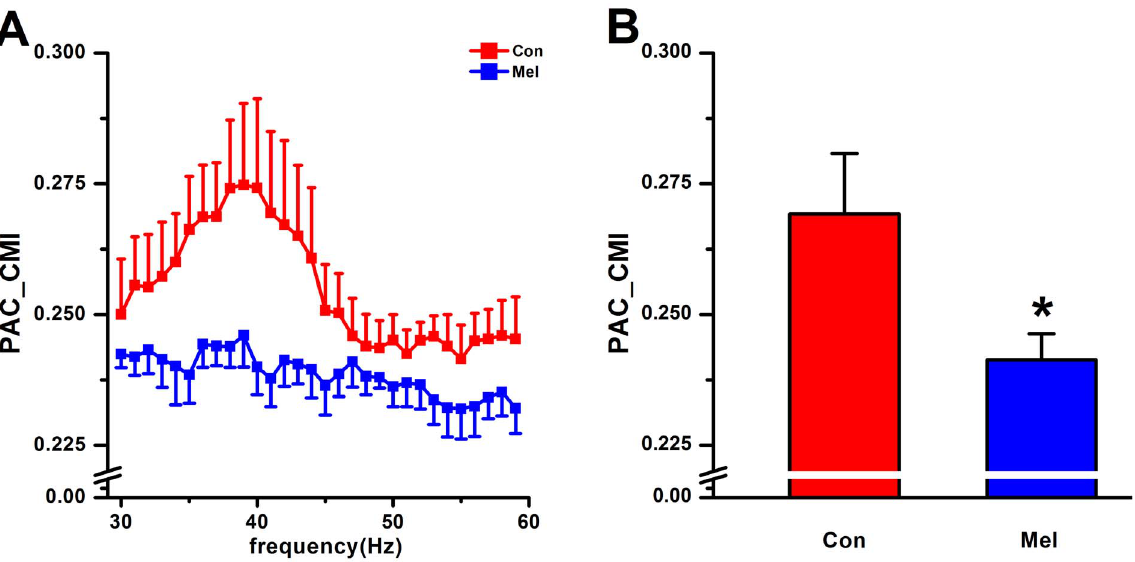
Figure 5. PAC-CMI analysis in CA3-CA1 network in Con and Mel groups. A. The comparison of coupling strength measured by PAC-CMI between Con and Mel groups ranged from 30 Hz to 60 Hz. B. The group data of PAC-CMI measures within the range of 30 Hz–45 Hz in Con and Mel groups. *P , 0.05 for comparison between Con group and Mel group.